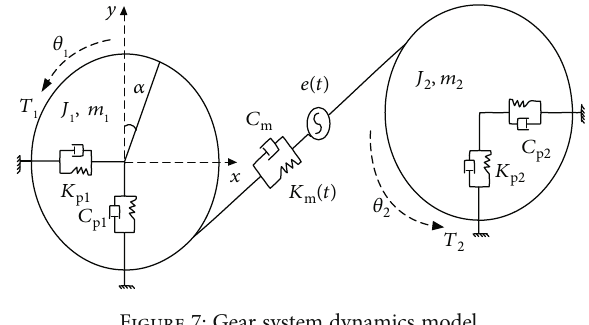
Figure 7: Gear system dynamics model. Table 3: Dynamic model parameters of gear